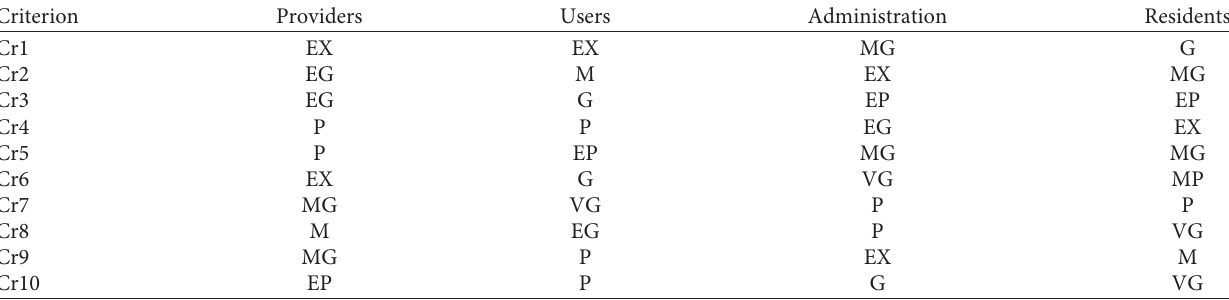
Table 2: Criteria importance evaluation by stakeholder groups.